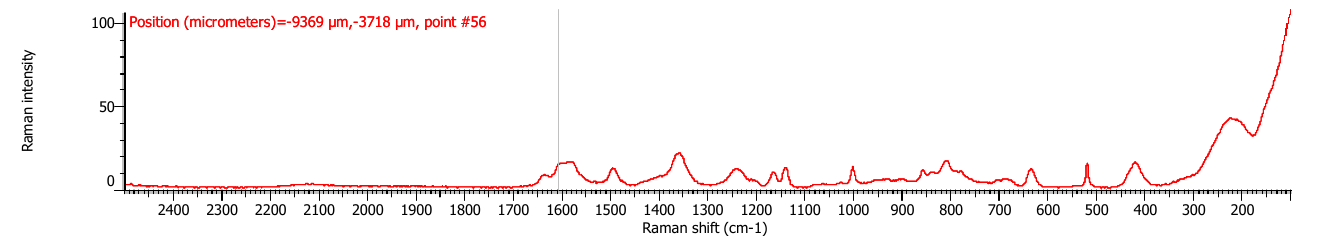
Figure 6. 1606 cm − 1 line Raman map, ZnO (pH10)/15 nm Cr/450 nm Ag nominal thickness (87GLAD).